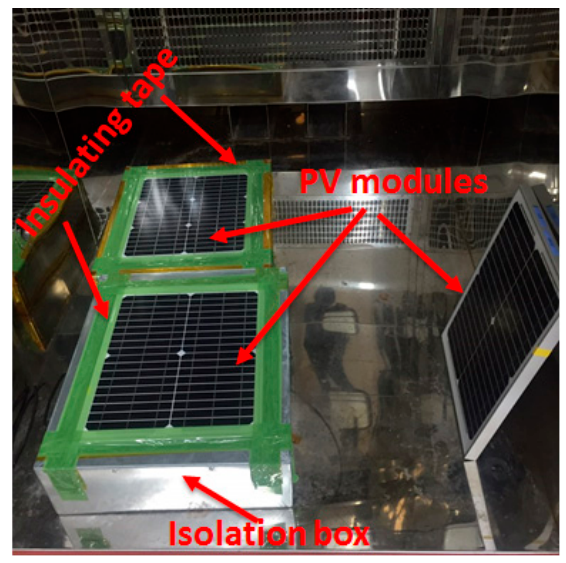
Figure 1. Optical image of photovoltaic (PV) modules inside the thermal cycling